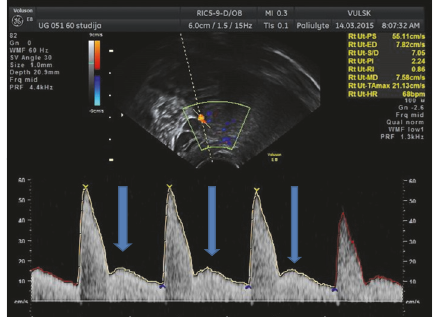
Figure 13: Notching of the uterine